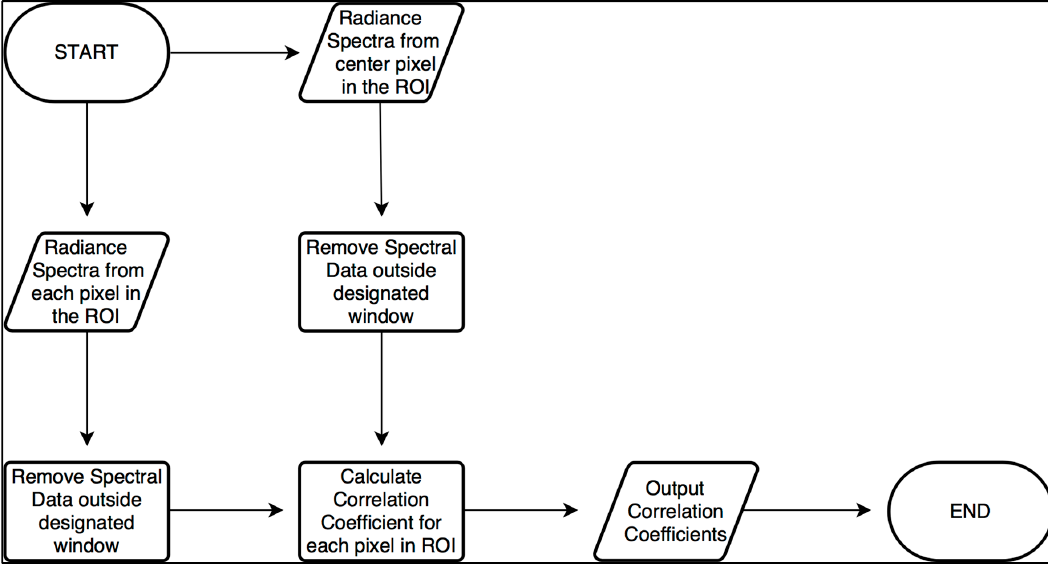
Figure 8. Schematic view of the basic algorithm for the application of the CC in the localization of finer errors in HSI data.